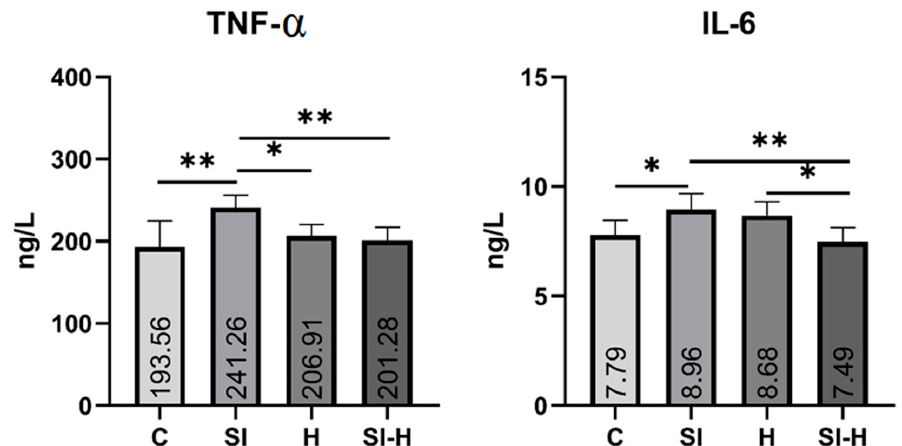
Figure 3. Comparison of molecular TNF- α and IL-6 between groups, Means and Std. Errors of the four groups for biochemical parameters. * p < 0.05, ** p < 0.01.